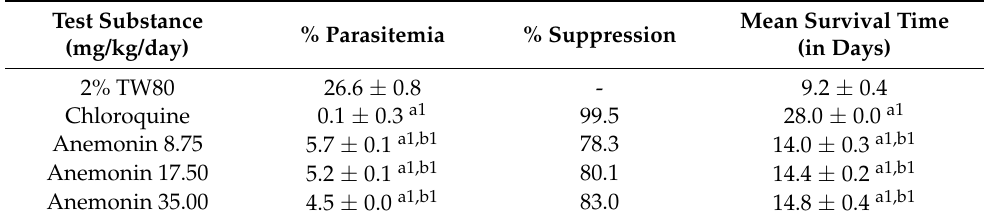
Table 4. Antimalarial activity of anemonin in mice infected with Plasmodium berghei in 4-day suppres- sive test.